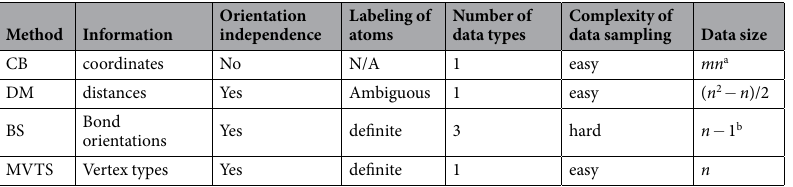
Table 1. Comparison of the four structural description schemes for clusters on high-symmetry lattice. CB: coordinate-based method; DM: distance-matrix method; BS: Balaban & von Sheleyer’s technique; MVTS: minimum vertex-type sequence. a m denotes the dimension of the system concerned. b If a structure is formed only from the main chain, the size of the descriptive data is ( n − 1); if a structure is branched, the data size is then greater than (n − 1).